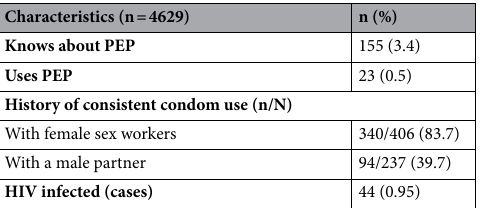
Table 1. Demographics and behavioral profiles of the participants before induction. PrEP pre-exposure prophylaxis, PEP post-exposure